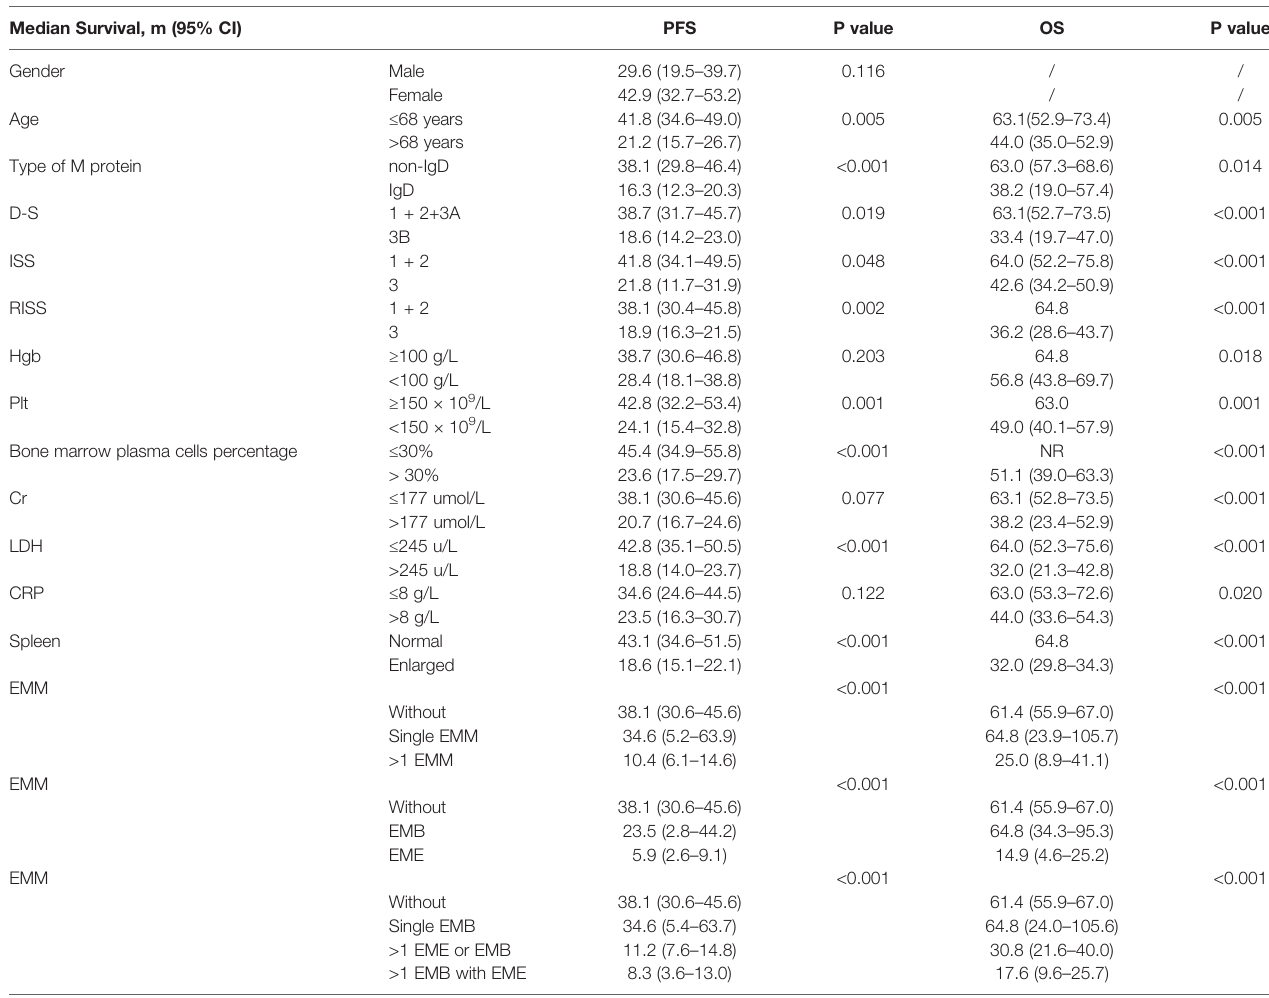
TABLE 2 | Survival of MM